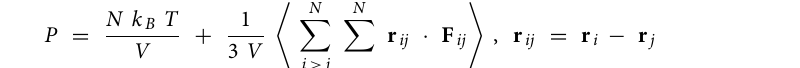
where ε is the depth of the potential well; σ is the distance at which the potential is zero; and r is the distance between the two particles. In addition, Thomas et al. 5 investigated the flow of water in a CNT and reported that